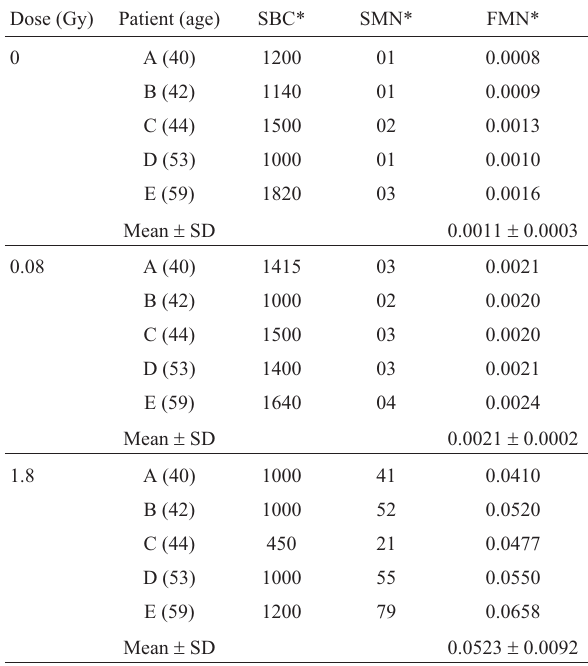
Table 3 - Distribution of the frequencies of micronuclei for the absorbed doses of 0 Gy (background), 0.08 Gy and 1.8 Gy. Dose (Gy) Patient (age)